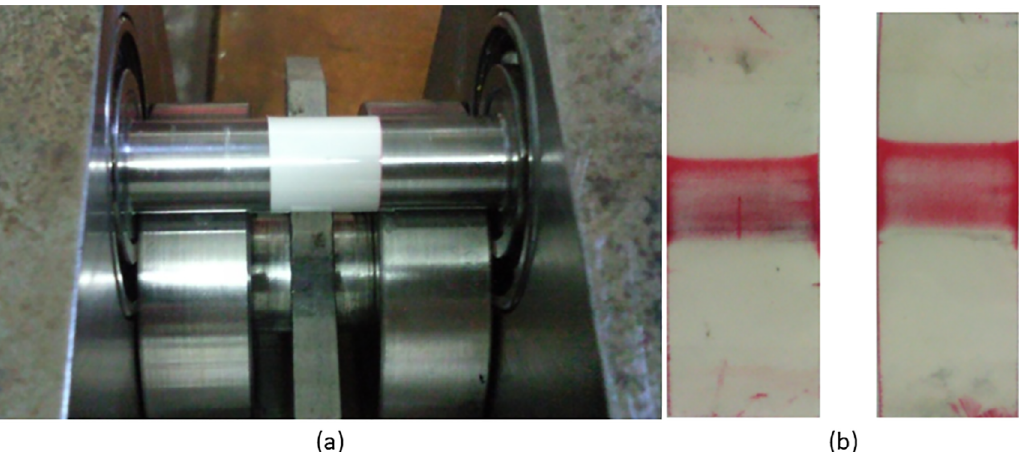
Figure 9. Pressurex® film applied to the strip during the BUT test (a) and after-test films (b).